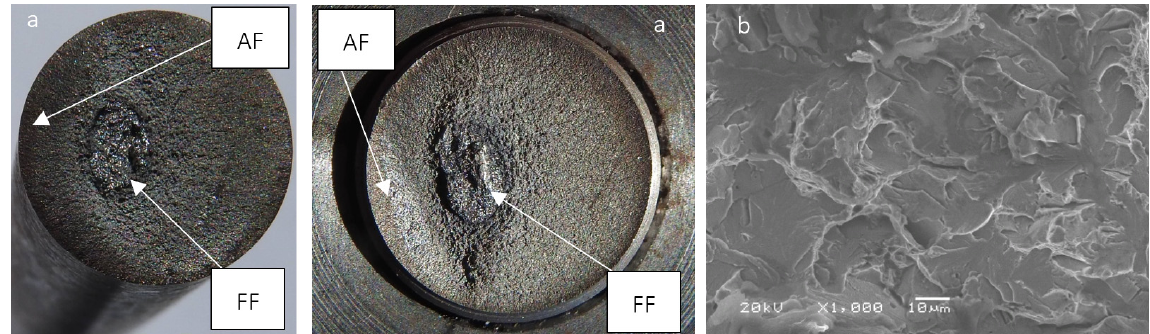
Figure 5. Sample macrographic image of the fatigue fracture and the micrographic image of the ad hoc fracture (AF-Ad hoc fracture, FF—Fatigue fracture). ( a ) macrographic view; ( b ) micrographic view